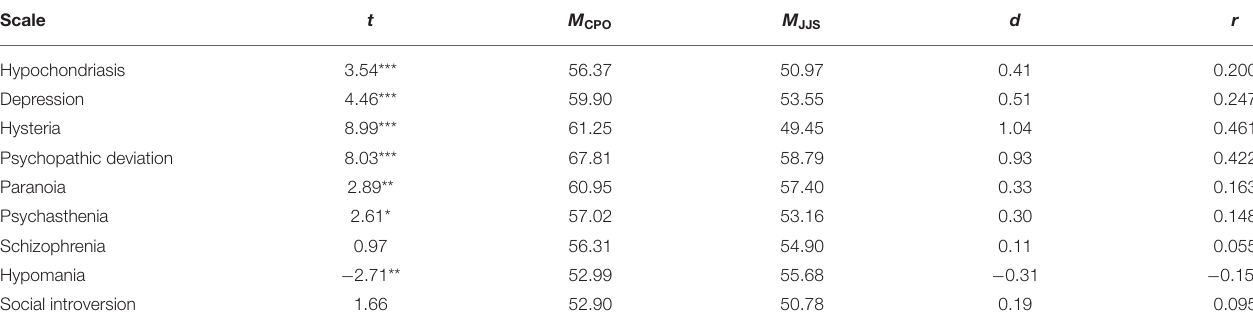
TABLE 5 | One-sample t -test for the mean comparison of CPOs with the mean of juvenile justice samples as test value in the basic clinical scales.